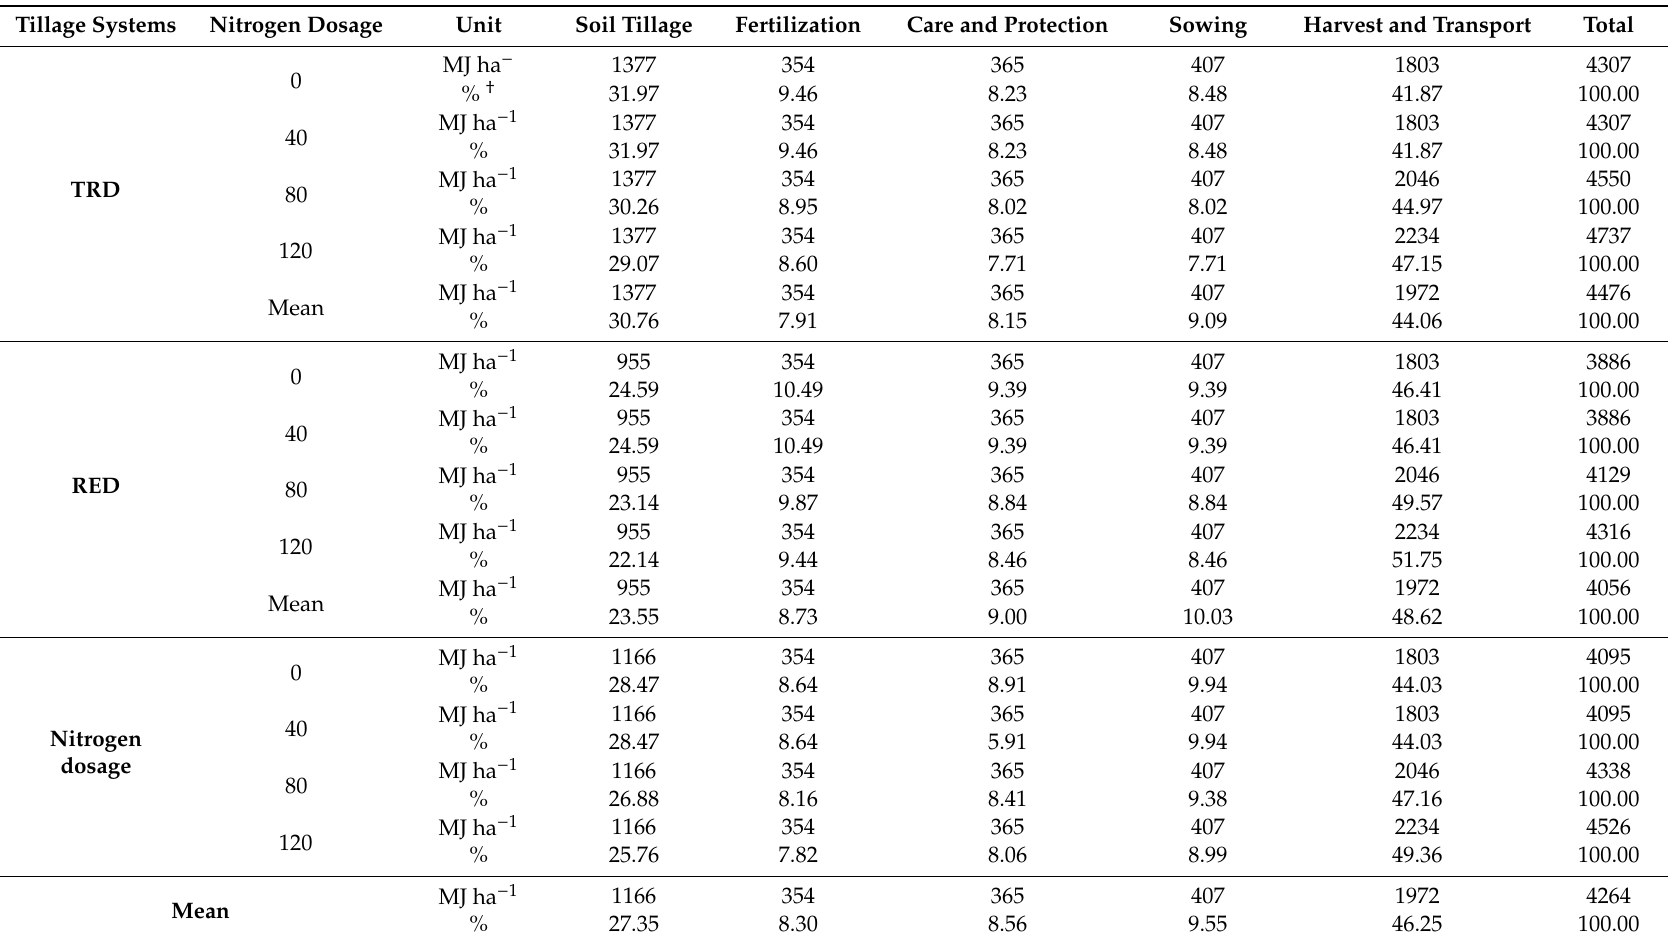
Table 5. Structure of the energy inputs in the cultivation of